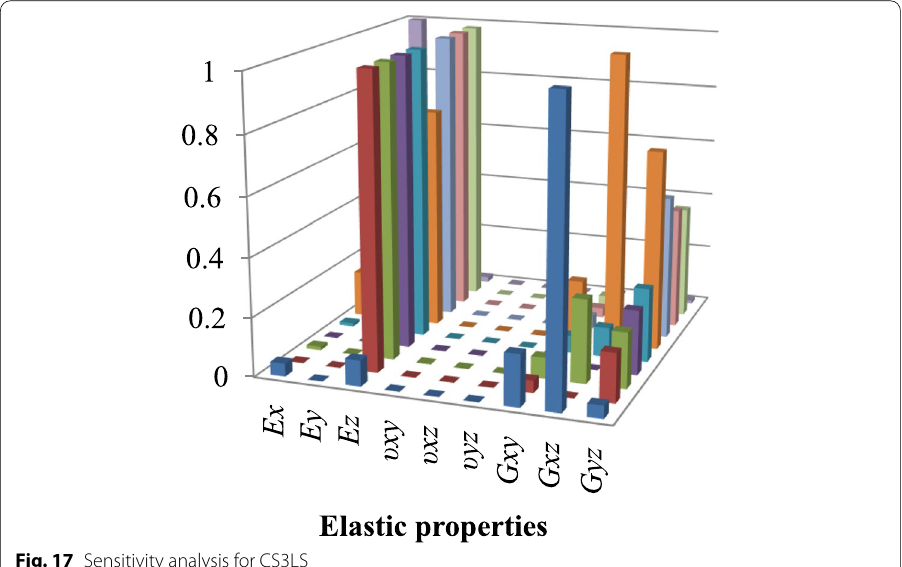
Fig. 17 Sensitivity analysis for CS3LS